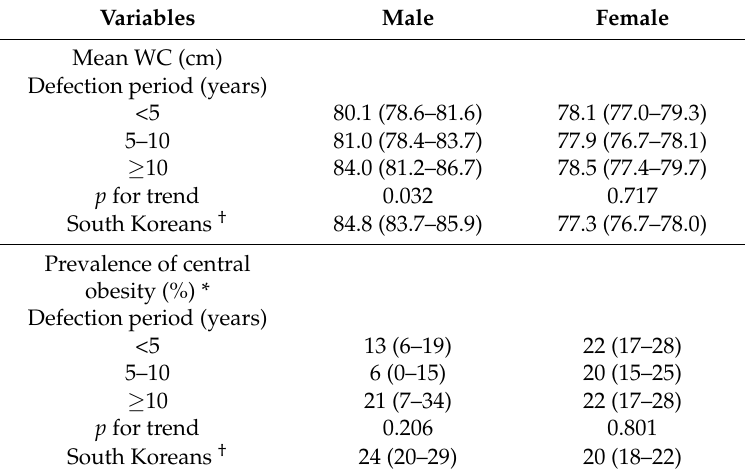
Table 3. The mean WC and central obesity prevalence among NKRs compared with South